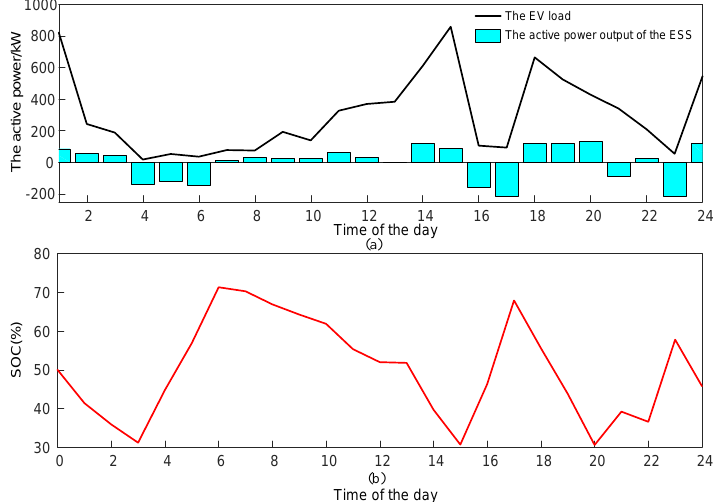
Figure 12. ( a ) The active power of the ESS at the FCS A under case 2. ( b ) The SOC of the ESS at the FCS A under case 2.